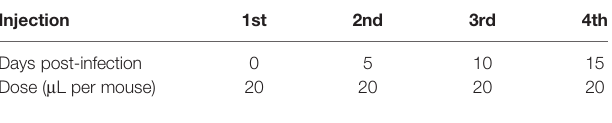
TABLE 1 | Injection time and dose of anti-asialo